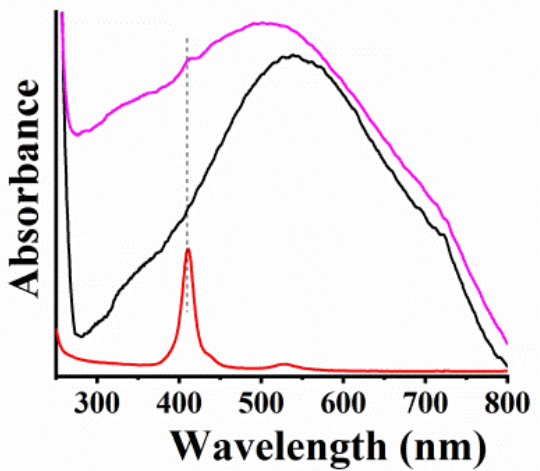
Figure 6. UV-Vis spectra for MoSe 2 -CoP (pink), MoSe 2 (black), and CoP (red), in dichloromethane. Next, electrocatalytic acidic HER for hybrids and reference materials was evaluated by recording linear sweep voltammetry (LSV). Notably, significant low onset potential was recorded for MoSe 2 -CoP at − 0.17 V vs RHE, lower than those recorded for MoSe 2 , f-MoSe 2 , and CoP at − 0.22, − 0.35 and − 0.28 V vs RHE, respectively (Figure 7a). The beneficial role of CoP was further revealed by evaluating the HER at − 10 mA/cm 2 . In fact, MoSe 2 -CoP operates HER at − 10 mA/cm 2 at − 0.31 V vs RHE, ca. 100 mV lower than that of MoSe 2 , at − 0.41 V vs RHE. For f-MoSe 2 and CoP, higher onset potential values are noted at − 0.47 and − 0.52 V, respectively. At the same time, hydrogen evolution for WSe 2 -CoP starts at lower potentials, at − 0.22 V vs RHE compared to reference materials, while the lowest potential value was required to drive HER at a reference current density of − 10 mA/cm 2 , at − 0.33